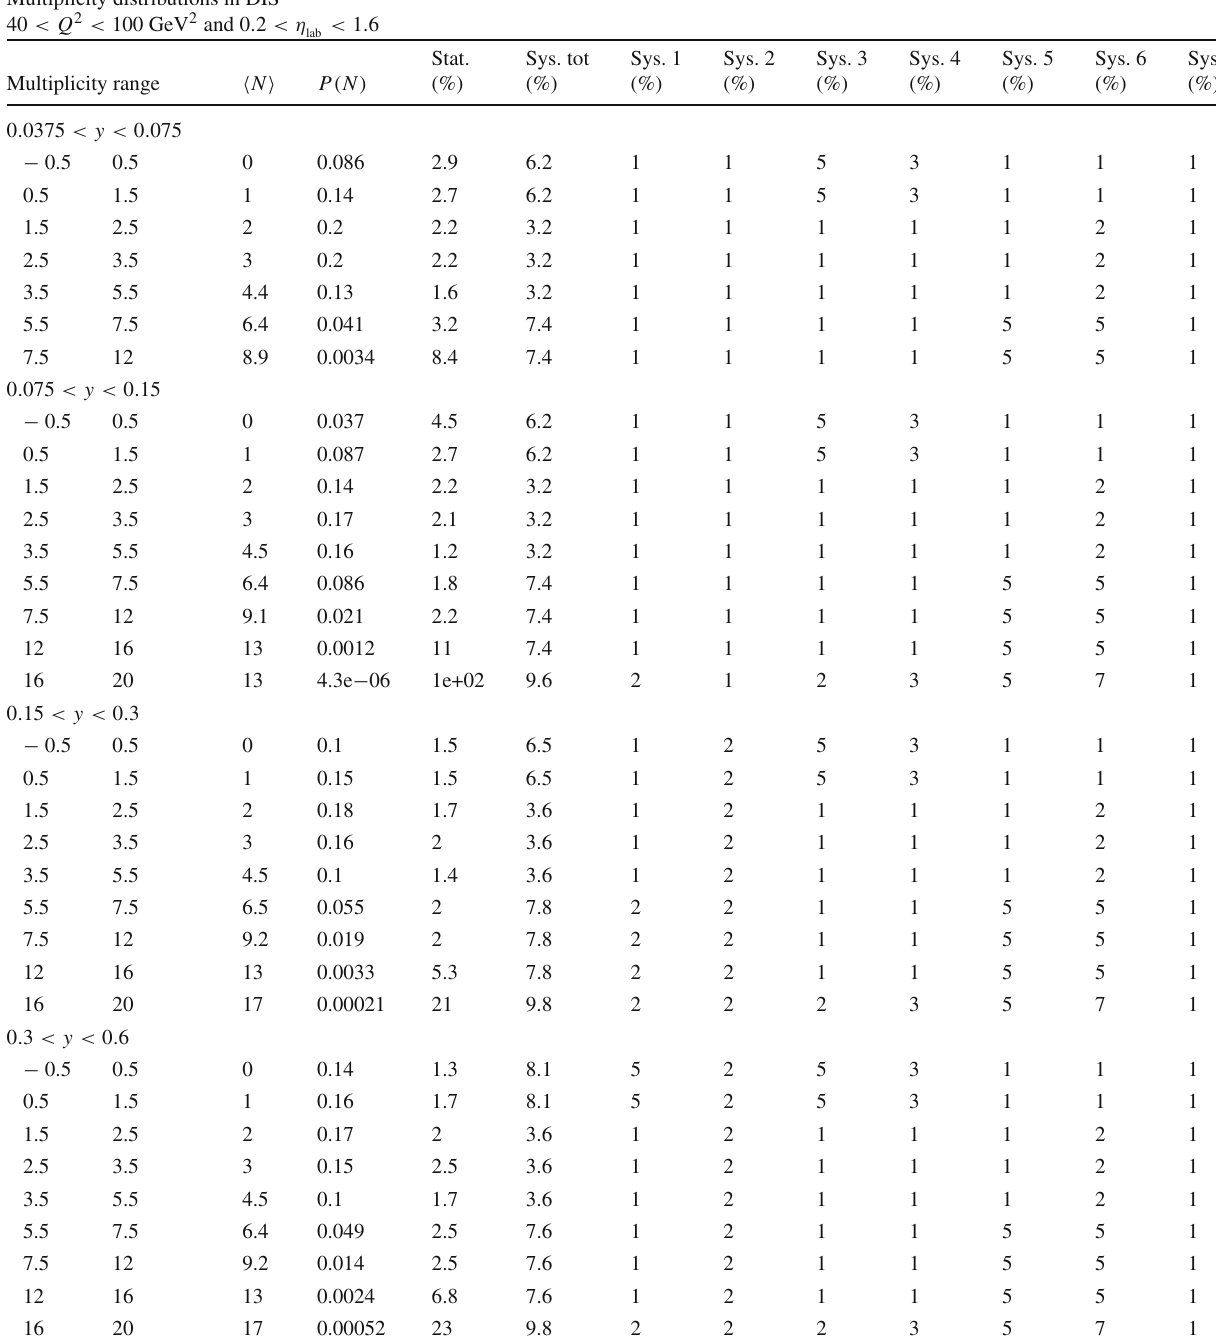
Table 24 Charged particle multiplicity distributions P ( N ) measured √ s = 319GeV with in the ranges of photon virtual- in ep DIS at ity 40 < Q 2 < 100 GeV 2 and charged particle pseudorapidity range Multiplicity distributions in DIS < 1 . 40 < Q 2 < 100 GeV 2 and 0 . 2 < η lab